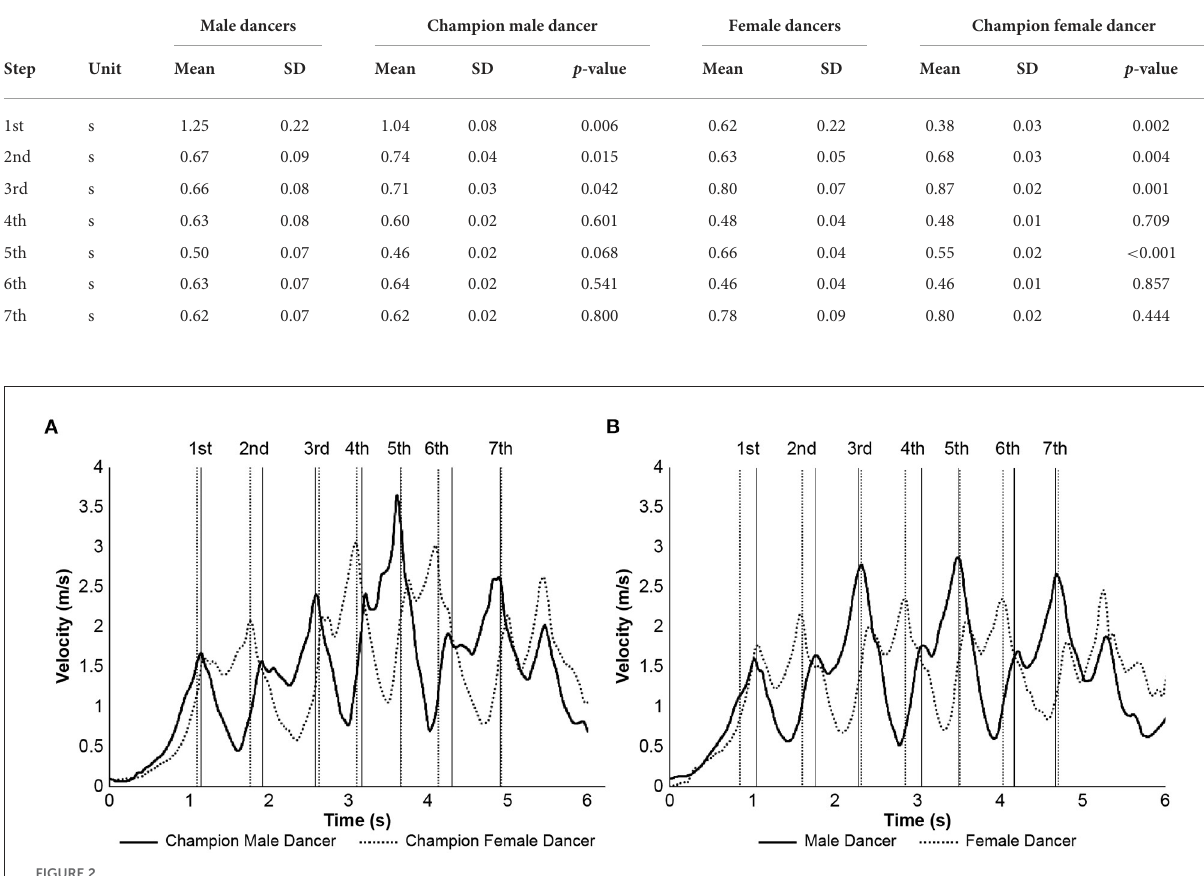
FIGURE2 Pelvic segment resultant velocities during the spin movement. The vertical line is the timing when the maximum value of each step for male and female is reached, and solid line is male and dotted line is female. (A) The champion male and female dancers. Solid line is male. Dotted line is female. (B) The control group male and female dancers. Solid line is male. Dotted line is female.